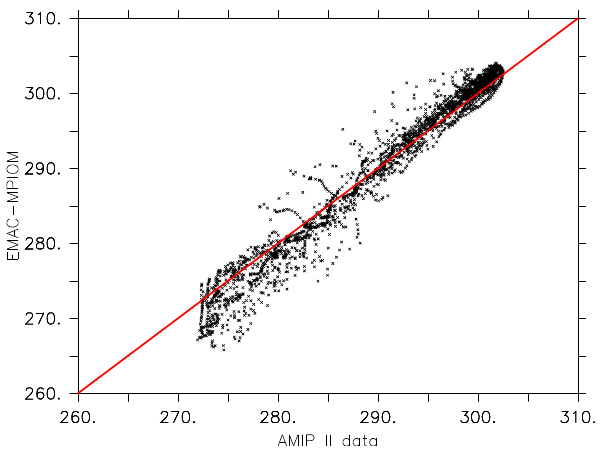
Fig. 5. Scatter plot of 1960–1990 average sea surface temperatures from the Taylor et al. (2000) dataset versus those resulting from simulation TRANS (in K).